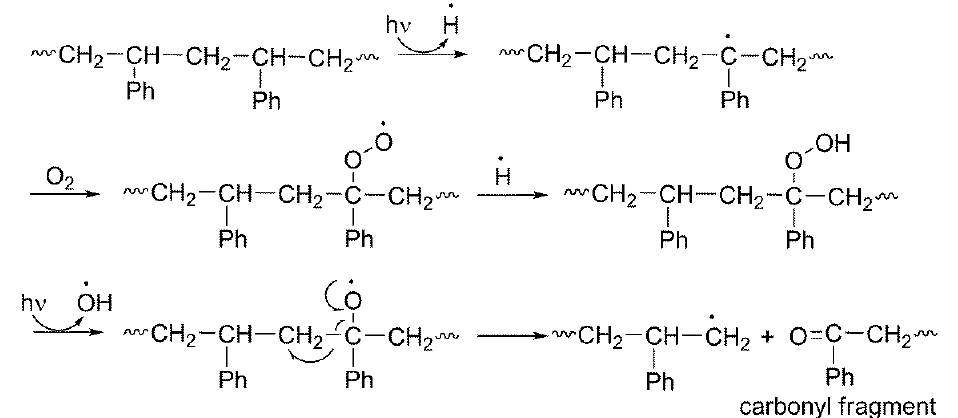
Figure 2. Formation of carbonyl fragments due to PS photo-oxidation.